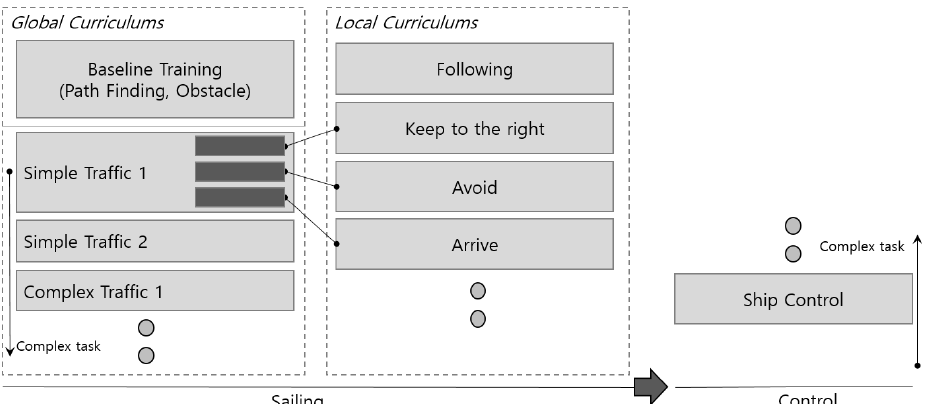
Figure 3. Curriculum classified into the global and local curriculums. The local curriculum is arranged based on the time and space sequence in the global curriculum. When learning to a given destination in the autonomous navigation is completed, sailing the learned autonomous navigation makes the control (the autonomous control) learn.